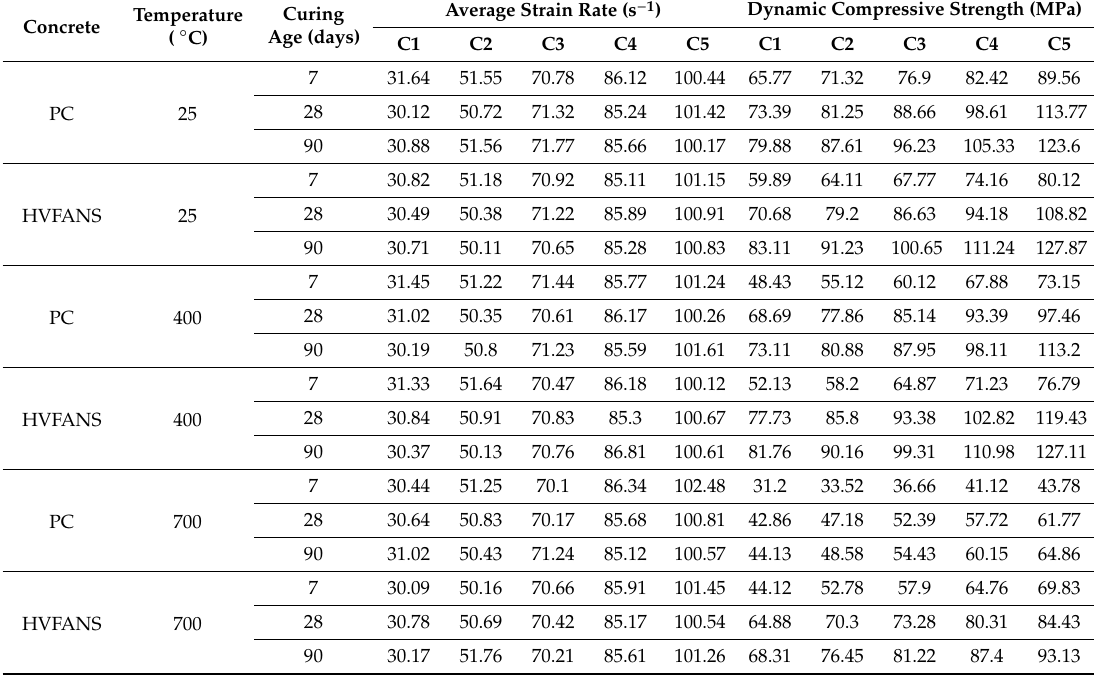
Table 5. E ff ect of curing age on dynamic compressive strength of PC and HVFANS concrete at di ff erent temperatures and strain